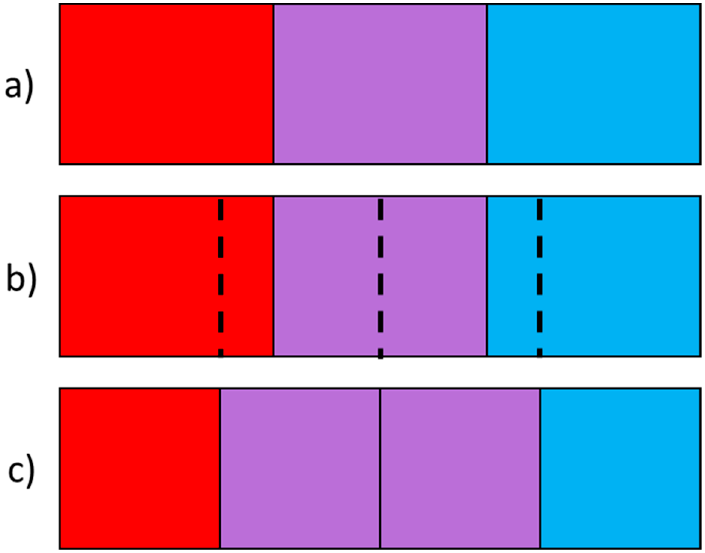
Figure 8. Example of a 3-mod solution generating the “best guess” to the solution of the 4-mod problem. ( a ) represents the hypothetical solution to a 3-mod problem, ( b ) is the 3-mod solution arranged as a pseudo-4-mod design, and ( c ) is the 4-mod design that most closely resembles ( b ), i.e., the best 4-mod guess.